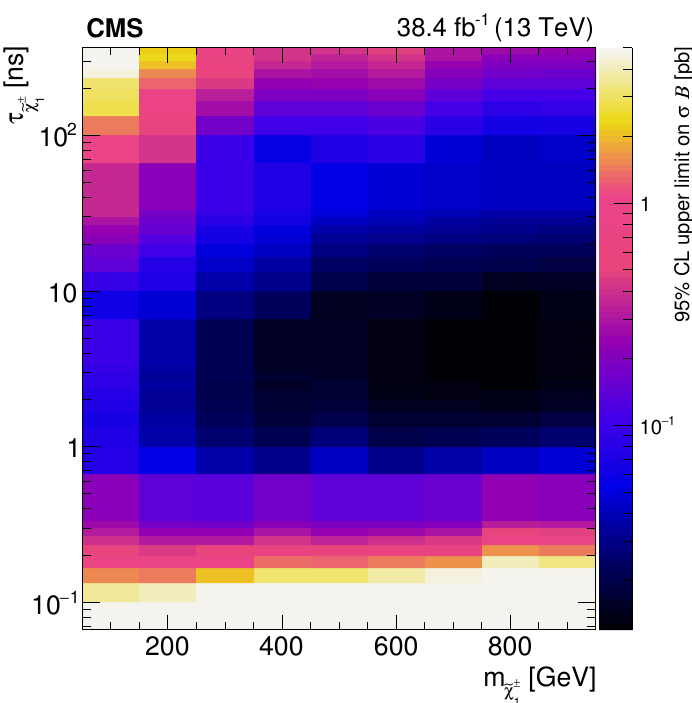
Figure 5 . The observed 95% CL upper limits on the product of the cross section for direct production of charginos and their branching fraction to lifetime. The direct chargino production cross section includes both in roughly a 2:1 ratio for all chargino masses considered.